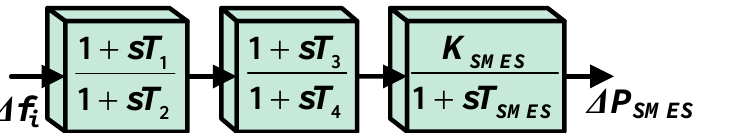
Figure 9. Transfer function-based circuit diagram of SMES.